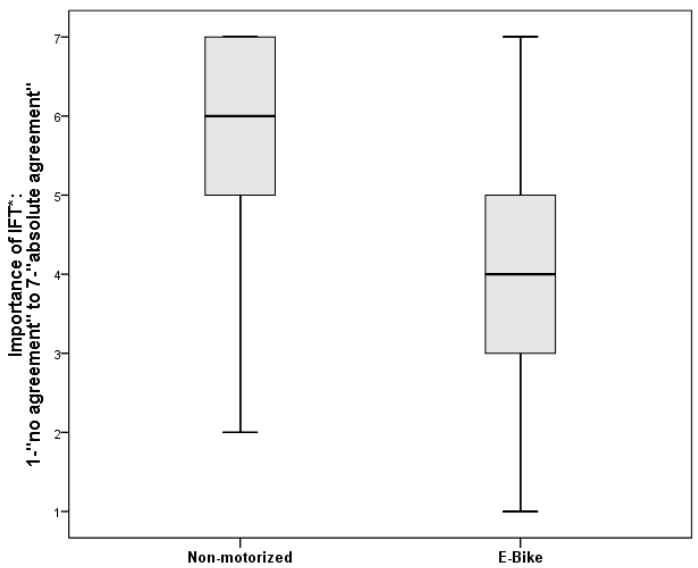
Figure 1. Comparison with boxplots: IFT (Intensive and fulfilling training)-Non-motorized vs. E-bike.